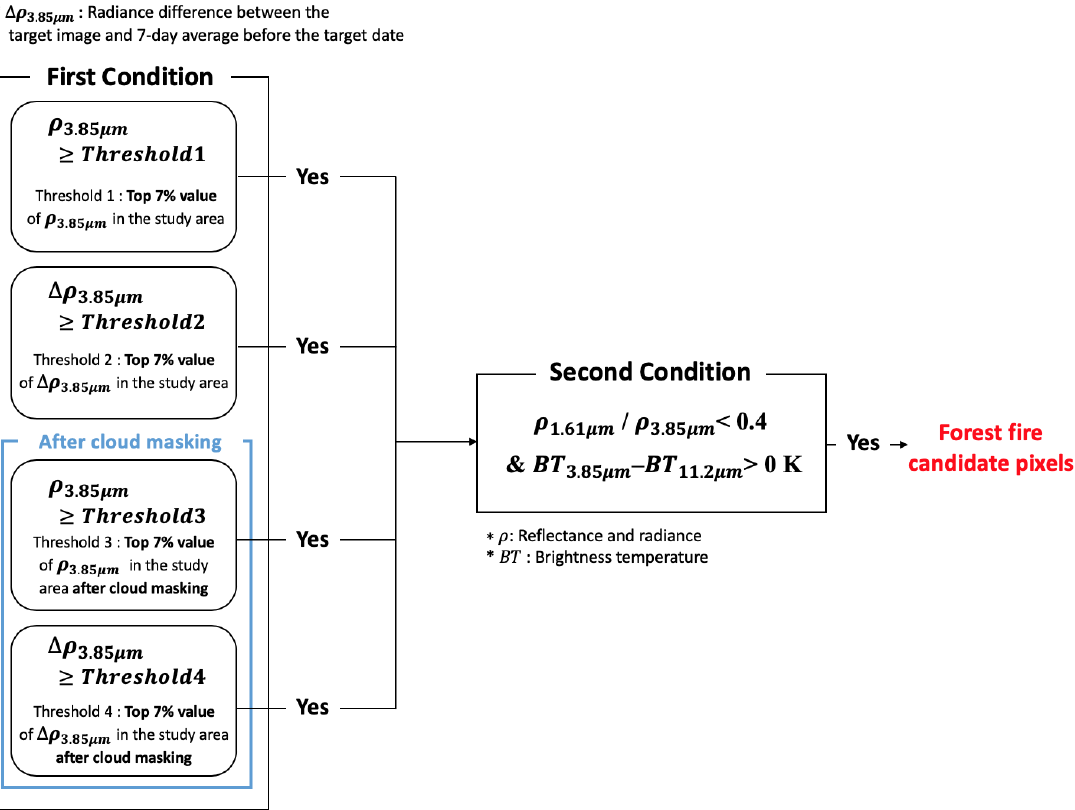
Figure 3. The threshold-based algorithm proposed in this